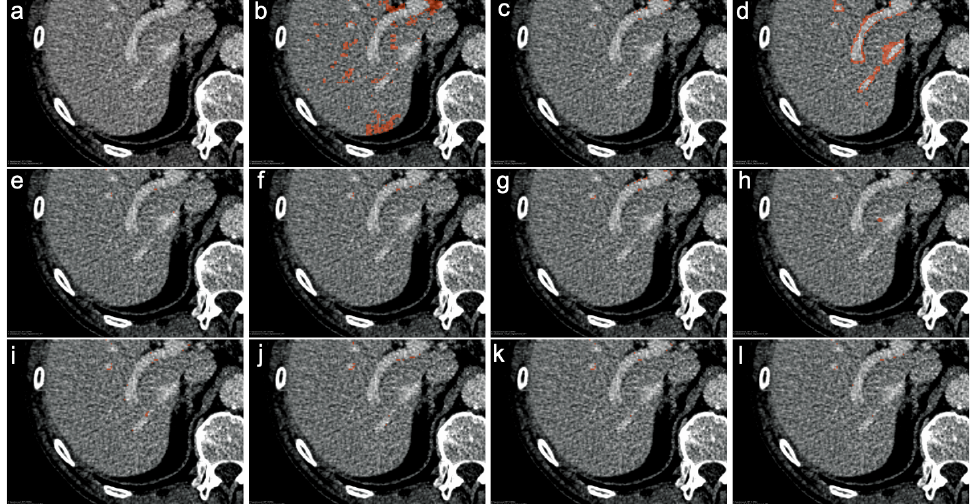
Figure 14. A slice in the CT images from test data followed by examples of over-segmentation (shown in red) from all image enhancements tested. ( a ) Original image, ( b ) Unenhanced, ( c ) Frangi, ( d ) Hessian, ( e ) Meijering, ( f ) Sato, ( g ) FrangiGC, ( h ) HessianGC, ( i ) MeijeringGC, ( j ) SatoGC, ( k ) SegAdded, ( l )